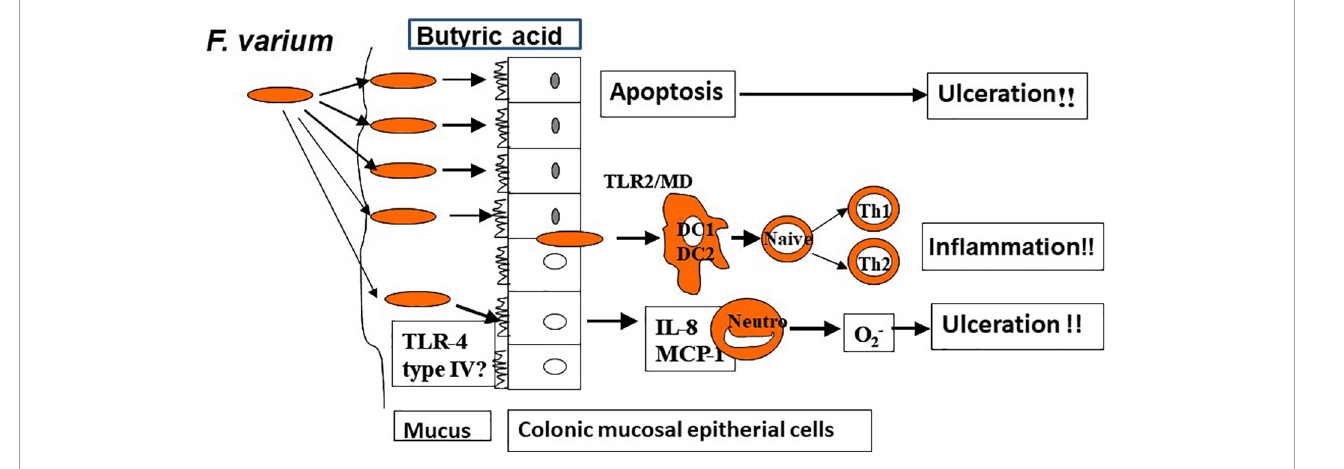
FIGURE2 Colonic ulceration and inflammation by Fusobacterium varium (hypothesis).